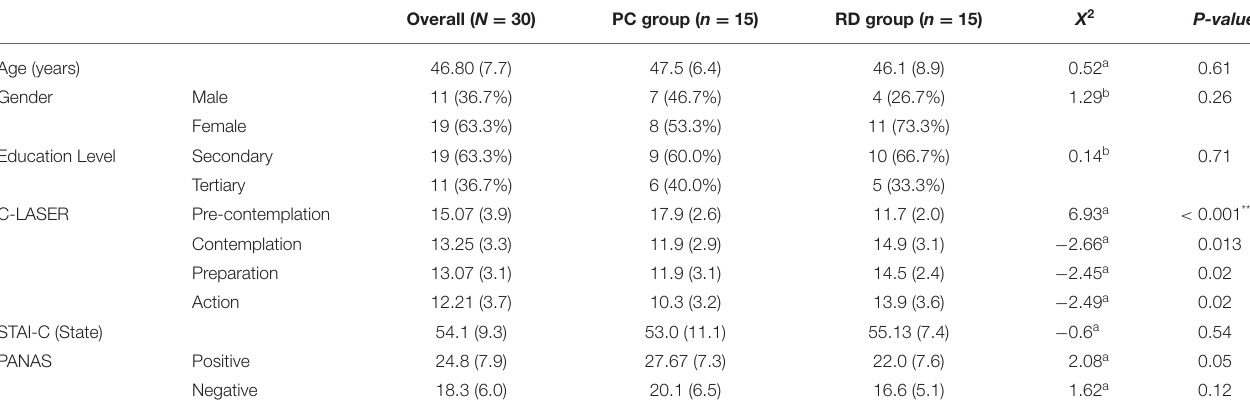
TABLE 1 | Demographic characteristics and test results of